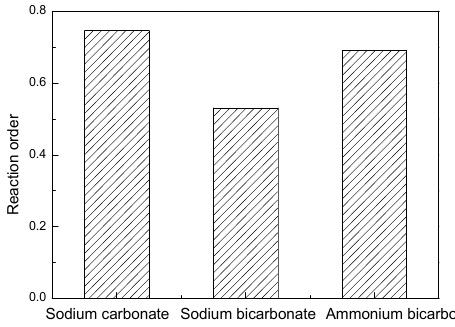
Figure 10. Relation between the leaching agent and the reaction order.